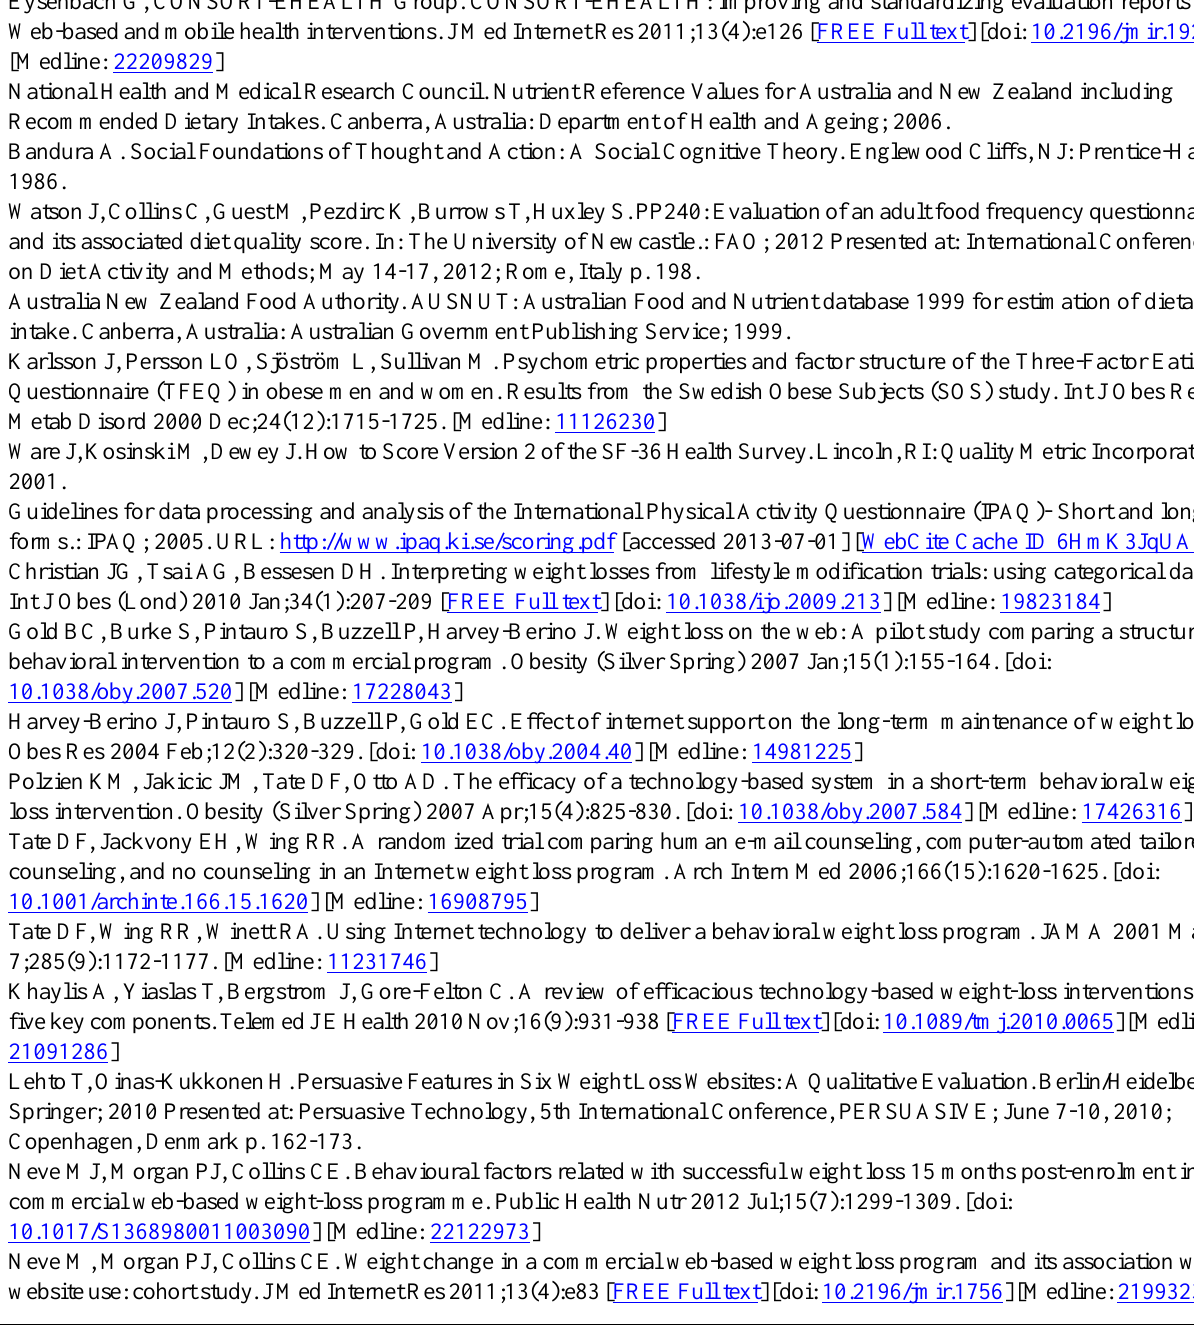
HDL: high-density lipoprotein IPAQ-SF: International Physical Activity Questionnaire-short form ITT: intention-to-treat LDL: low-density lipoprotein